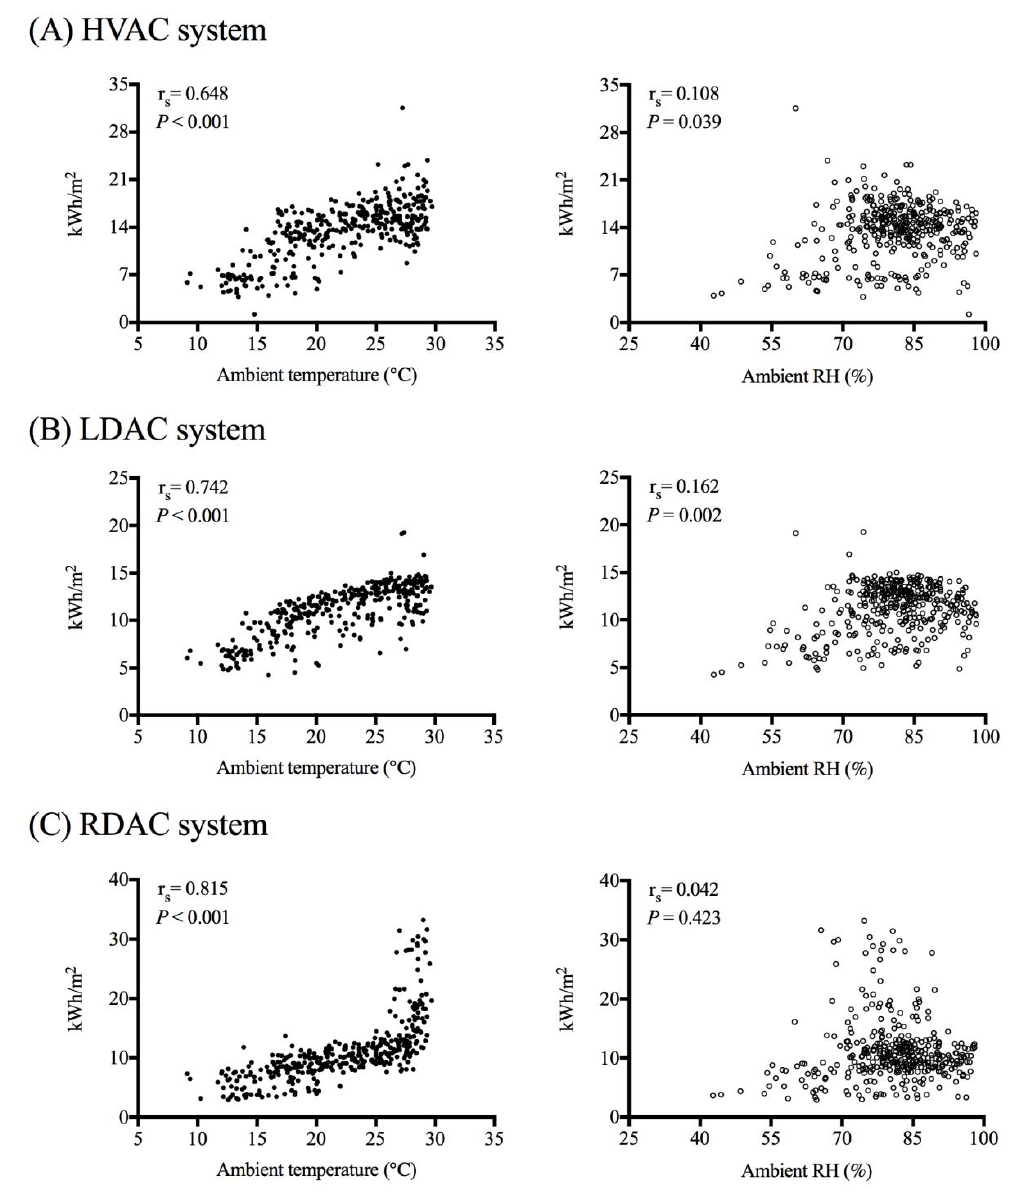
Figure 3. Association between daily ambient temperature / RH and daily total energy consumptions of HVAC ( A ), LDAC ( B ), and RDAC ( C ) systems.